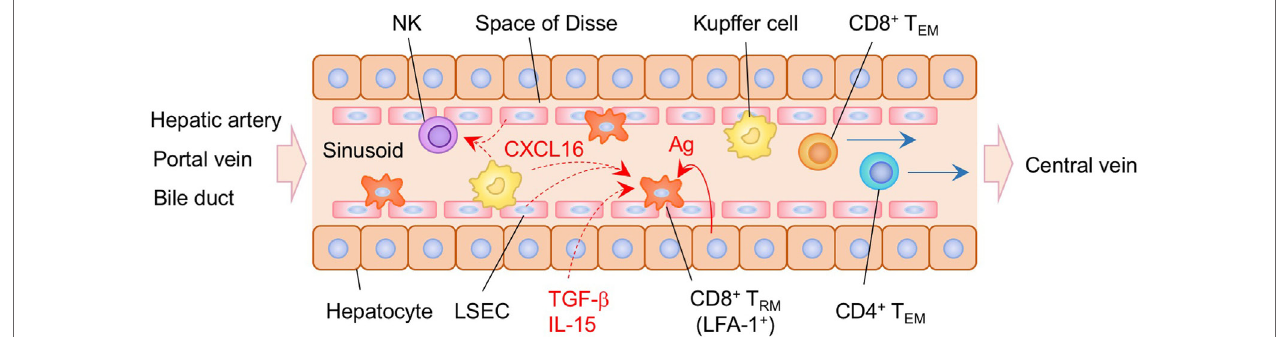
FiGURe 7 | T RM niches in the in the liver. CD8 + T RM cells are localized within the sinusoid of the liver. These cells exhibit an amoeboid shape and crawling along the sinusoid dependent on the expression of lymphocyte function-associated antigen 1 (LFA-1). Antigen expressed on the hepatocytes play a key role in the establishment of CD8 + T RM cells in the liver sinusoid. Kupffer cells and NK cells are also resident populations in the sinusoid. CXCL16 secreted by Kupffer cells and liver sinusoidal endothelial cells (LSEC) may promote the retention of T RM cells and NK cells within the sinusoid. T EM cells are passing through the sinusoid without crawling. Orange and blue cells indicate CD8 + and CD4 + T RM cells, respectively, unless otherwise stated. A red line indicates the representative niche factor that influences the maintenance of T RM cells. Blue lines indicate the migratory route. Dashed lines indicate potential impact of niche factors. Abbreviations: Ag, antigen; T RM , tissue-resident memory T cells; T EM , effector memory T